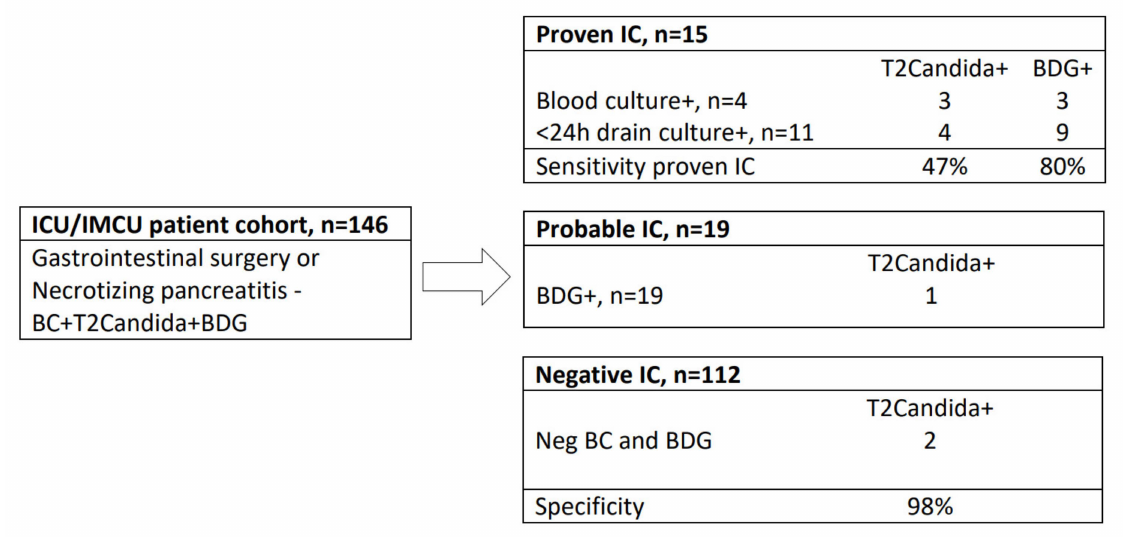
Figure 1. The T2Candida assay identified 3/4 BC+ IC and was in concordance with